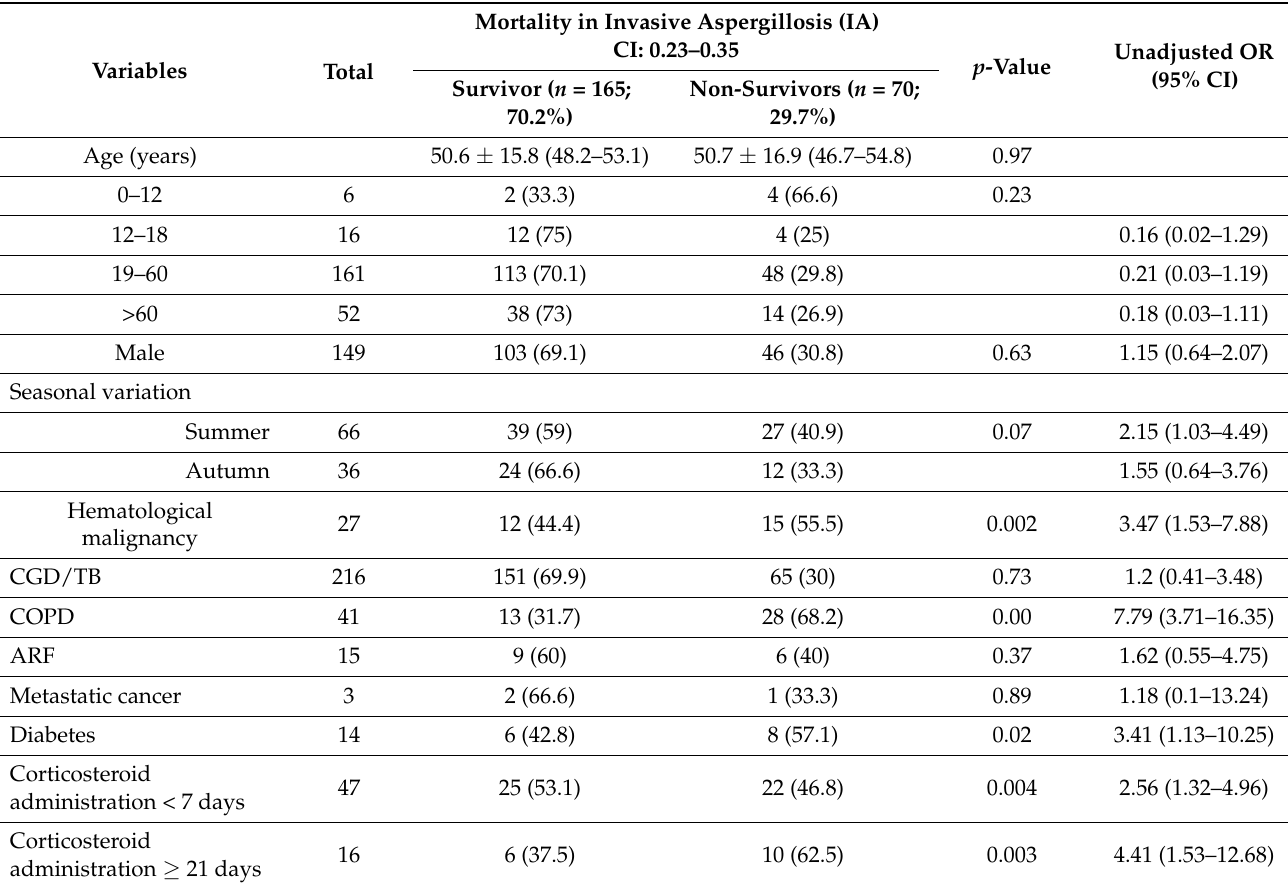
Table 1. Socio-demographic and underlying conditions of the patients enrolled in the